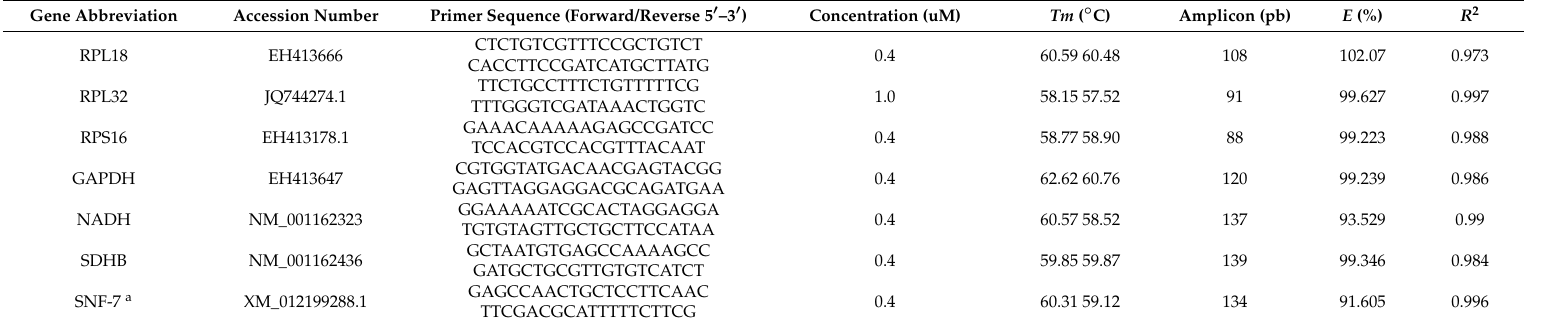
Table 1. Description of the candidate reference genes and SNF7 for RT-qPCR